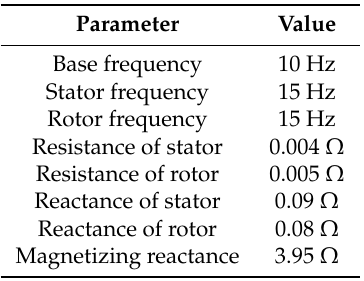
Table 2. Induction Generator